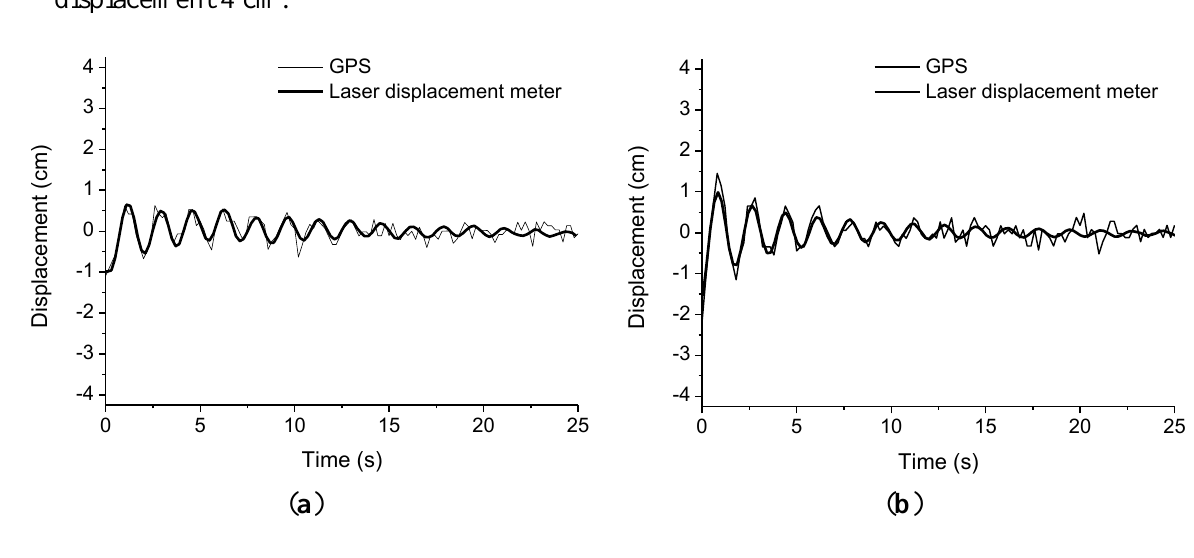
Figure 3. Displacement measurement by GPS and laser displacement meter: ( a ) Initial displacement 1 cm; ( b ) Initial displacement 2 cm; ( c ) Initial displacement 3 cm; ( d ) Initial displacement 4